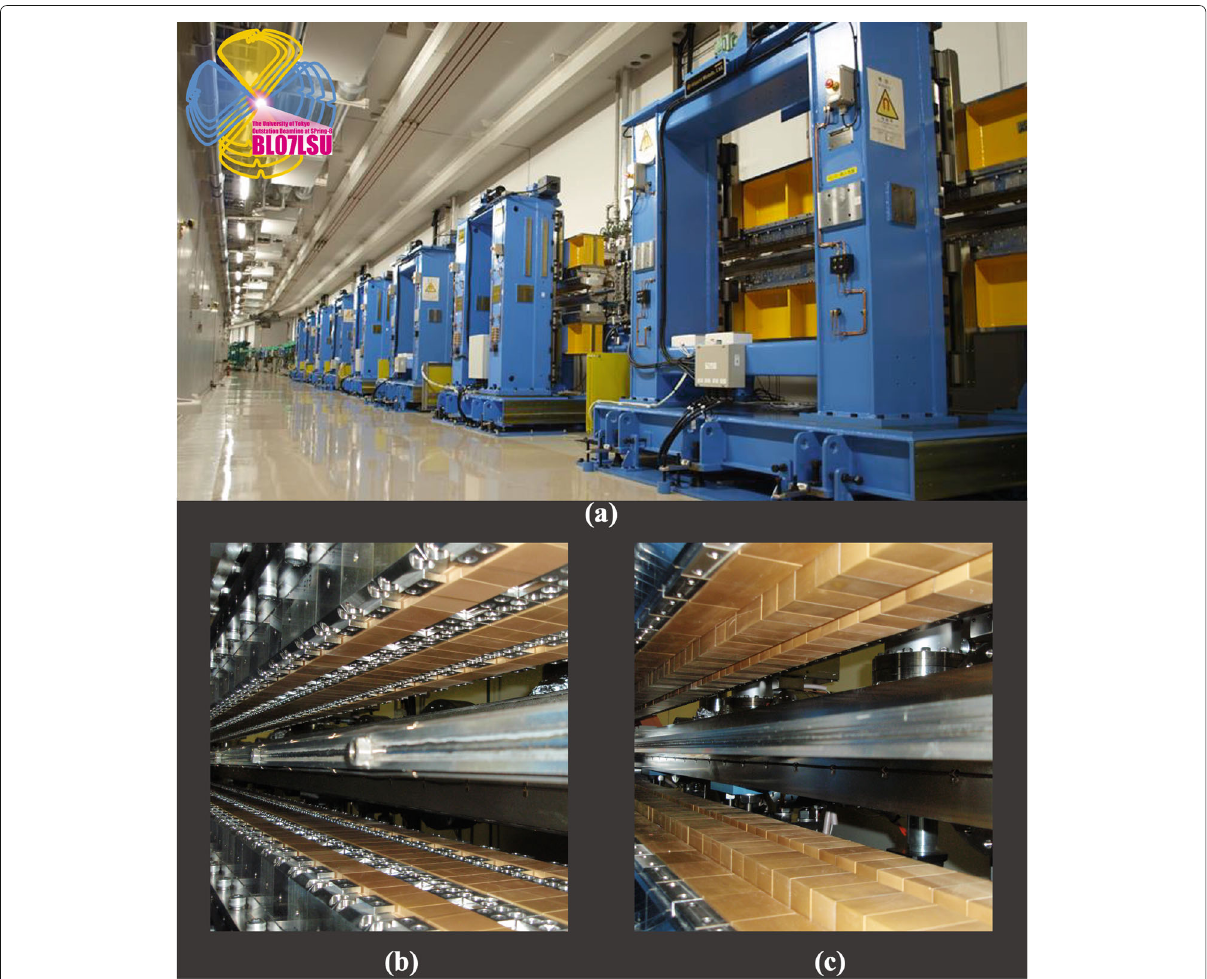
Fig. 1 Photos of the first segmented cross undulator, “ID07,” installed at the University-of-Tokyo Outstation Beamline for Materials Science, SPring-8 BL07LSU [27]. a A set of the eight ID segments of undulators. b , c Arrays of magnets in b the horizontal figure-8 undulator segment and c the vertical figure-8 undulator segment S N is the spectral profile of the normal undulator radi- ation, and S M represents the interference between IDs.